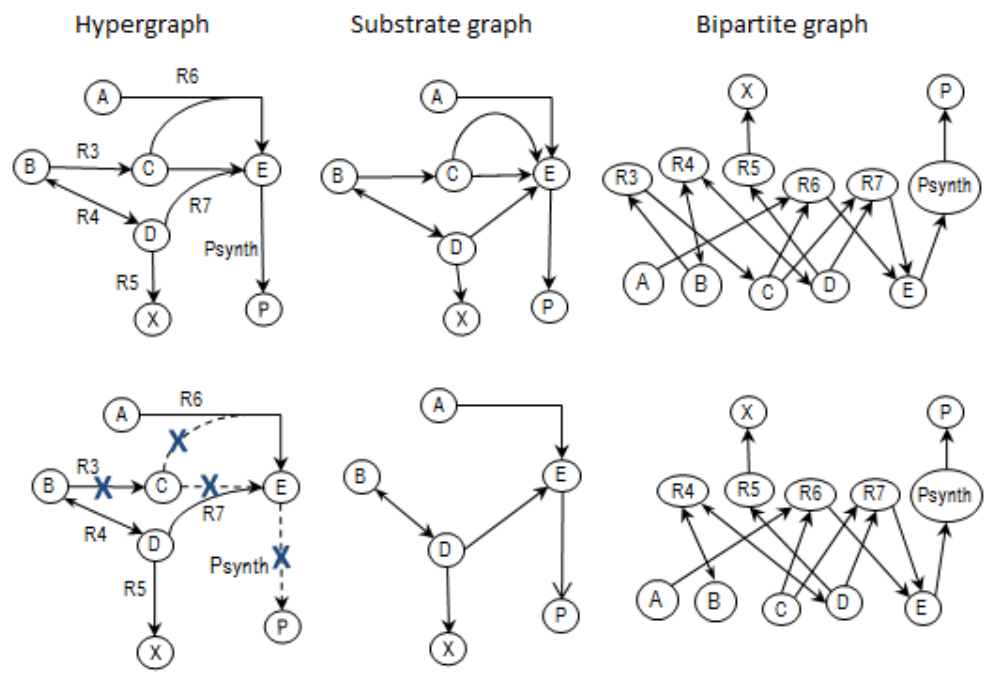
Figure 6. Hypergraph showing reactant and product nodes of R6 and R7 of NetEx with corresponding versions of substrate and bipartite graphs. In the lower hypergraph, removing R3 means no C is formed and a consequential removal of R6 and R7, which means that PSynth cannot